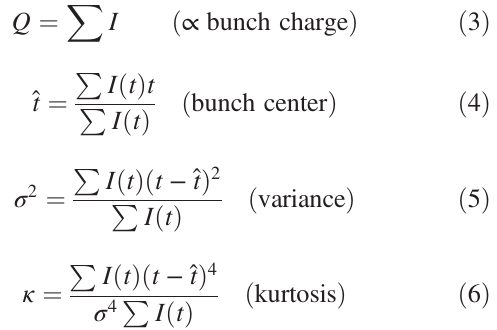
FIG. 13. Evolution of the longitudinal beam profile of the initially unbunched ion beam during the cooling process mea- sured at different electron pulse lengths. (a) 500 ns, (b) 700 ns, (c) 900 ns. The color scale corresponds to an arbitrary unit of beam current and is normalized to an independent measurement of the respective dc current prior to cooling for the sake of comparability. The apparent increase in total intensity over time results from the inability of the BPM to detect the dc component of the beam. The nonuniform intensity distribution of the cooled ion bunch is identical among independent experiments and was also observed in our previous simulations, particularly for shorter electron pulses [5].